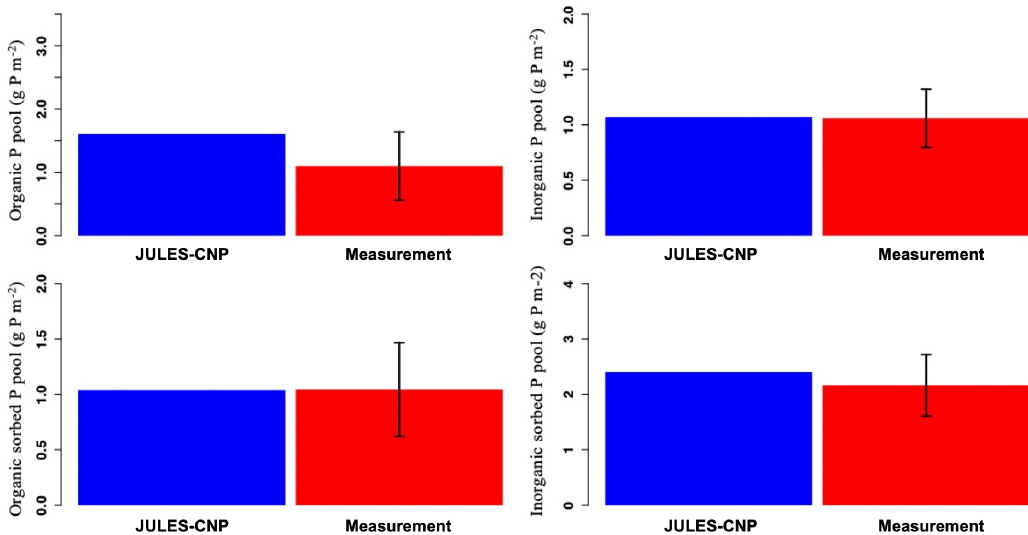
Figure 2. Modelled vs. measured soil phosphorus pools under ambient CO 2 (for the soil depth of 0–30cm). The black line represents the standard deviation. Table 6. Observed and simulated phosphorus pools and fluxes. Occluded and weathered P pools were prescribed using the observed values (for